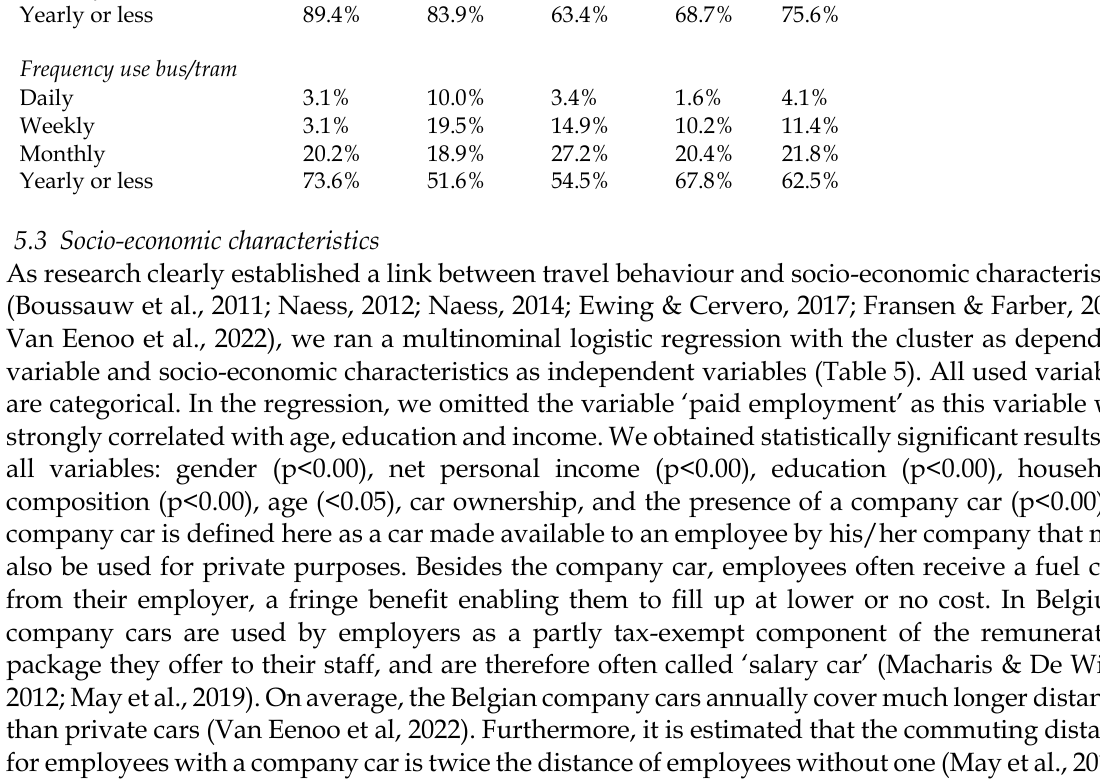
Table 5: Contingency table of socioeconomic variables and significance based on